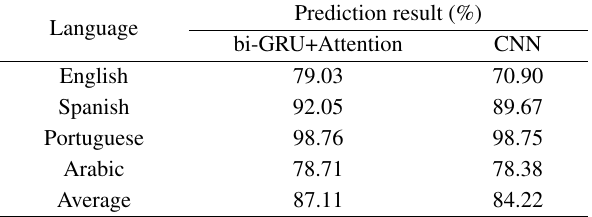
Table 15 Prediction results obtained for language variety classifcation using bi-GRU+++ Attention and CNN by Kodiyan et al.